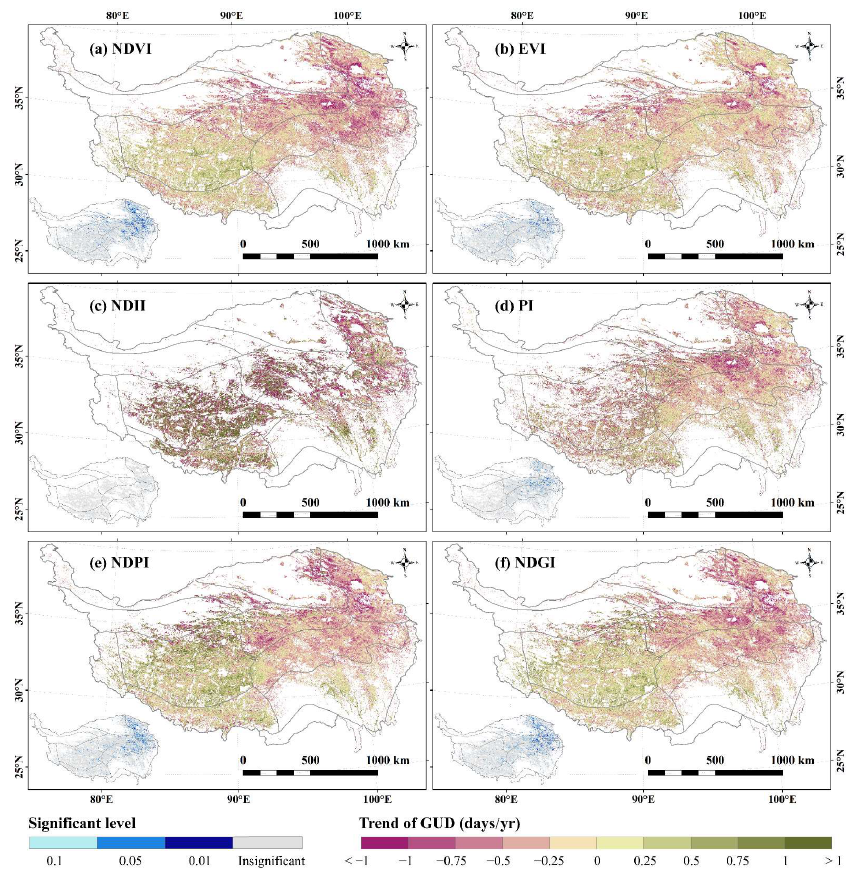
Figure 2. The spatial variation in the multi-year mean GUD during 2003–2020 derived from each of the six VIs (NDVI, EVI, NDII, PI, NDPI and NDGI) averaged over the four methods (β max , CCR max , G20 and RC max ). The line chart in the lower left of each subgraph displays the cumulative percentage of GUD pixels for each vegetation type.